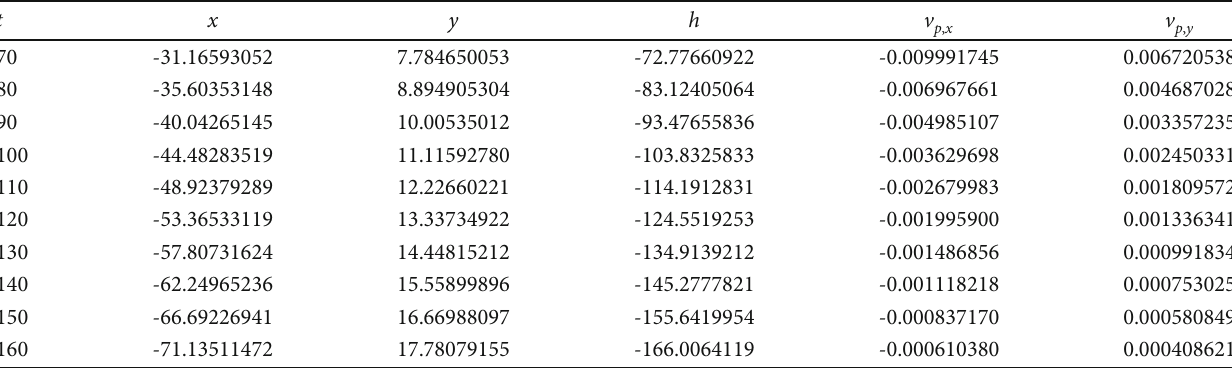
Table 1: The position of the crest of rational solution v